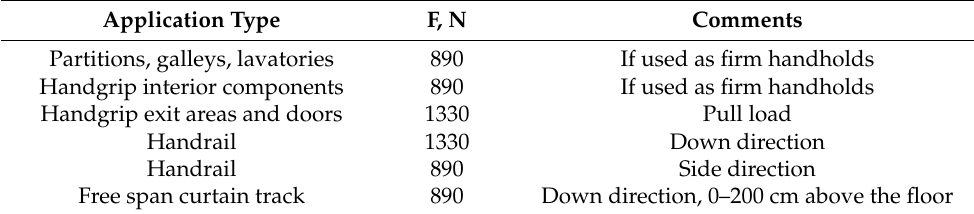
Table 2. Concentrated loads subjected to some aircraft interior parts [11].